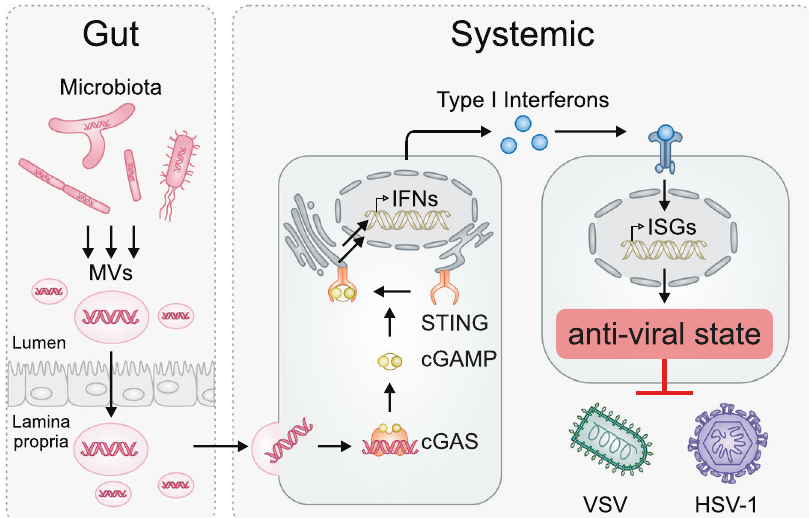
Fig. 1 Activation of cGAS-STING-dependent type I IFN signaling via DNA-containing membrane vesicles released by gut microbiota. Bacterial DNA-containing MVs are released by the microbiota in the gut and cross the epithelial barrier. In MV-targeted cells, the DNA is recognized by cGAS, which synthesizes the second messenger cGAMP. cGAMP binds and induces oligomerization and translocation of STING from the ER to the Golgi, eventually causing induction of type I IFNs. Secreted IFNs are recognized by IFN-receptors resulting in the activation of a signaling cascade leading to the induction of hundreds of ISGs, which set cells in an antiviral state. MVs membrane vesicles, IFN interferon, cGAS cyclic GMP – AMP synthetase, cGAMP cyclic guanosine monophosphate – adenosine monophosphate, STING stimulator of interferon genes, ISG interferon-stimulated gene, VSV Vesicular stomatitis virus, HSV-1 Herpes simplex virus